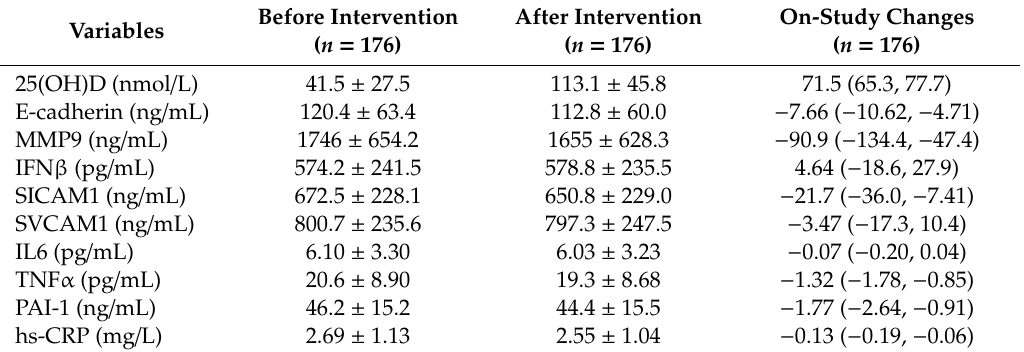
Variables Changes